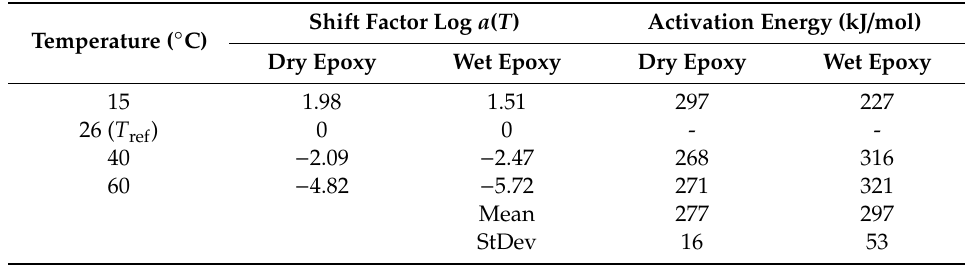
Table 1. Experimentally determined TTSP shift factors for creep compliance of dry and wet epoxy. The mean is obtained as the best fit of the curves in Figures 4 and 5. StDev stands for standard